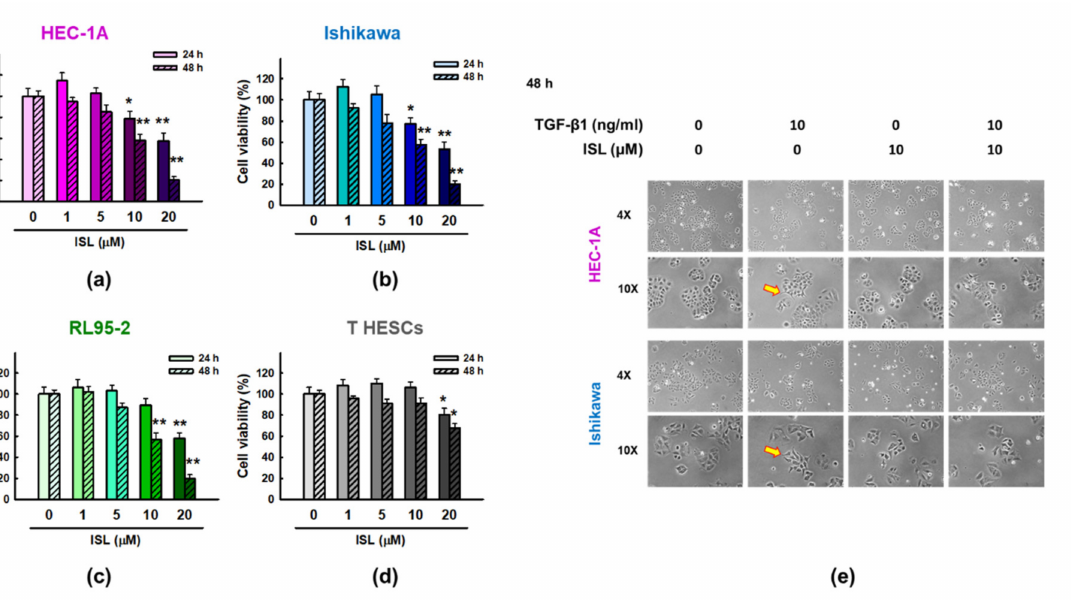
Figure 1. The effect of ISL at various concentrations on human endometrial cancer cells and human endometrial stromal cells. HEC-1A ( a ), Ishikawa ( b ), RL95-2 ( c ), and T HESCs ( d ) cells were treated with ISL (1, 5, 10, and 20 µ M) for 24 h and 48 h. The cell viability was measured using the MTT assay. ( e ) Representative phase–contrast images showing the morphological changes of HEC-1A cells and Ishikawa human endometrial cancer cells treated without or with 10 ng/mL of TGF- β 1 and 10 µ M of ISL for 48 h.Images were captured at 400 × magnification. The yellow arrow indicated the location of cells with spindle shape. The values were expressed as the mean ± SD of three independent experiments. * p < 0.05, ** p < 0.01 compared to the vehicle